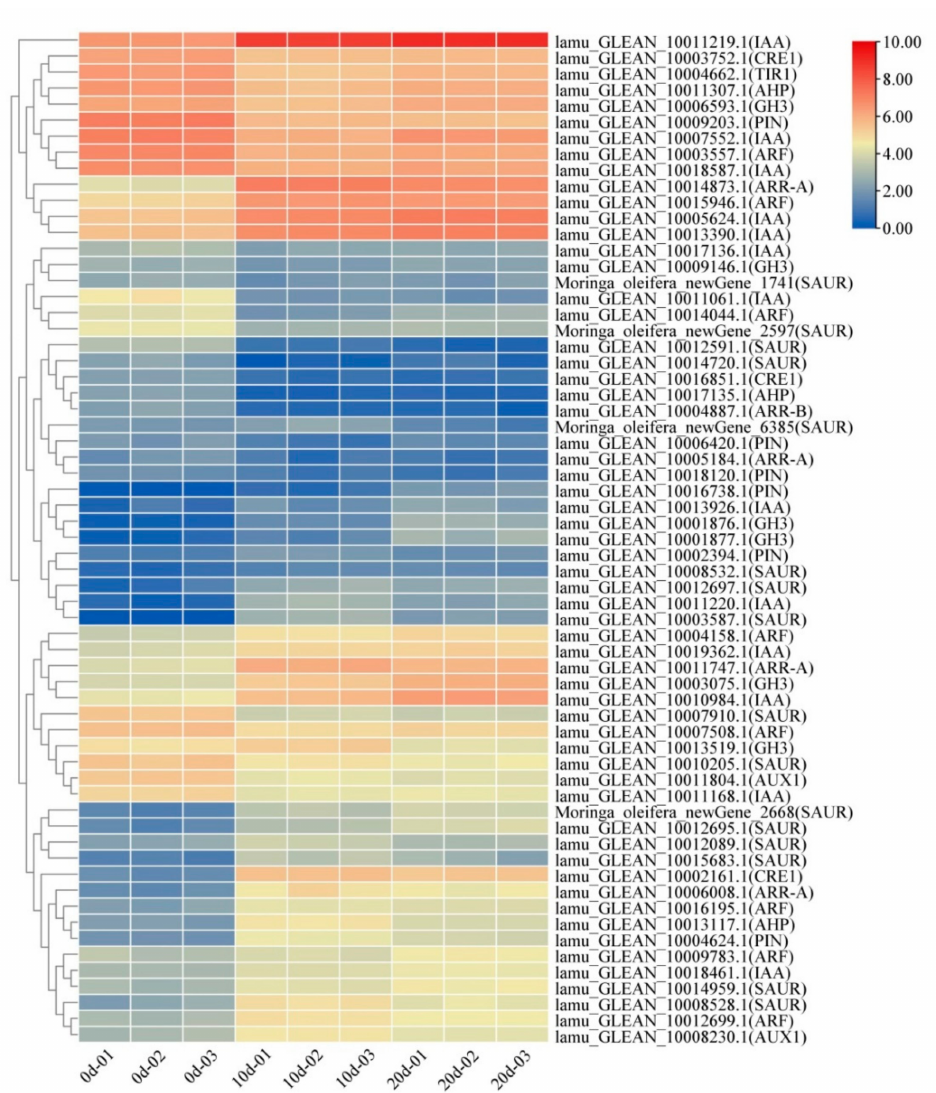
Figure 4. Heatmap of differentially expressed genes related to auxin and cytokinin metabolism. Columns and rows in the heatmap represent samples and genes, respectively. Samples’ names are shown below the heatmaps. The color bar explains the scale used to indicate the genes’ expression levels. The scale represents the logarithm of FPKM value of gene